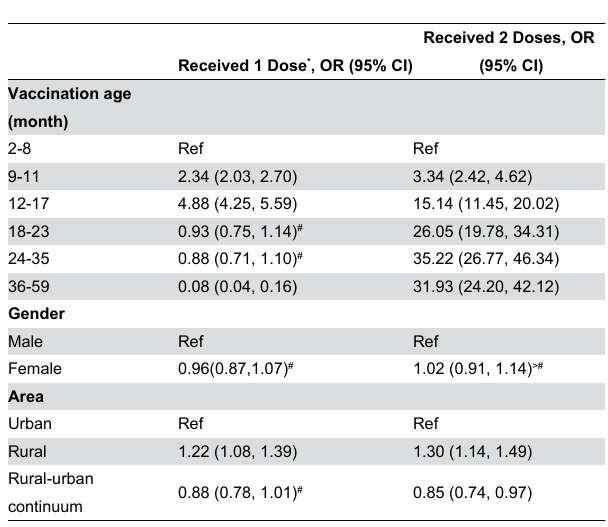
Table 2. Factors associated with LLR vaccine uptake among children ages 2-59